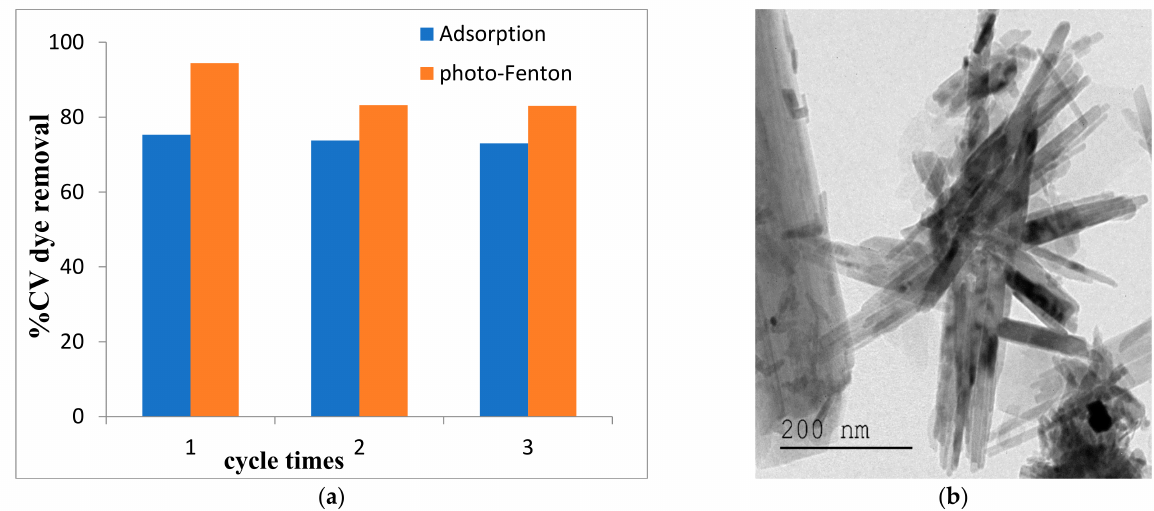
Figure 9. ( a ) Removal efficiency of CV dye by natural iron oxide with different cycles; ( b ) TEM image after three successive